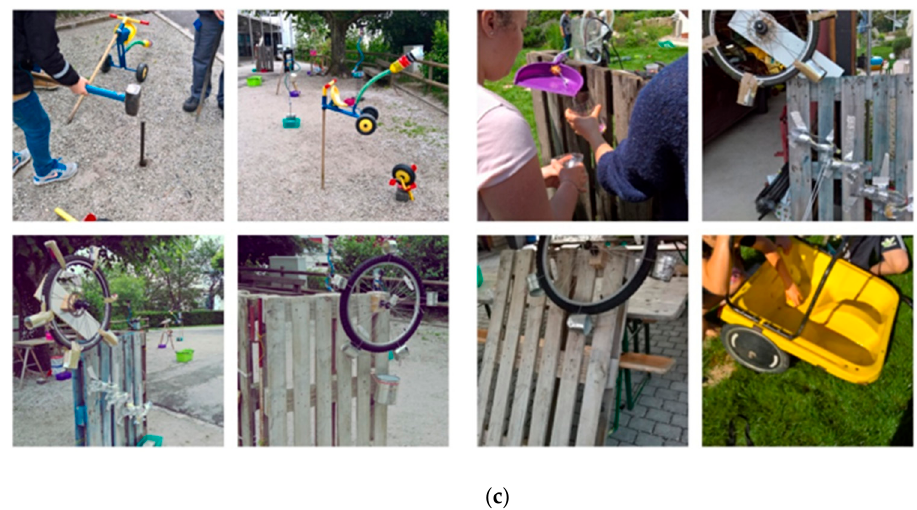
Figure 2. ( a ) Research of fountain project (design and realization of fountains with recycled materials). ( b ) Research and experimentations of pupils during the design stage. ( c ) Fountains made by pupils during the Creative and Manual Activities in the compulsory schooling.